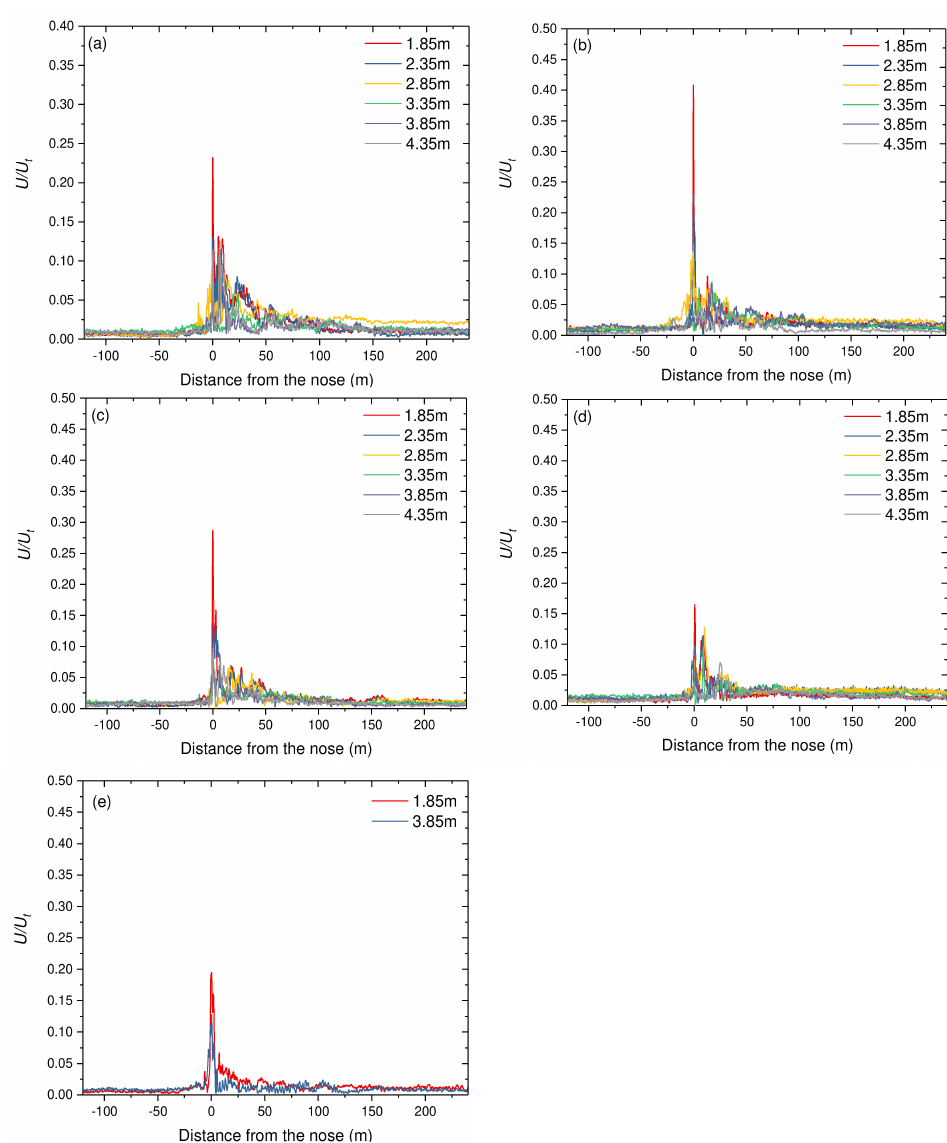
Figure 5. The normalised ensemble horizontal velocity: ( a ) H = 0.54 m; ( b ) H = 0.87 m; ( c ) H = 1.21 m; ( d ) H = 1.55 m; ( e ) H = 1.88